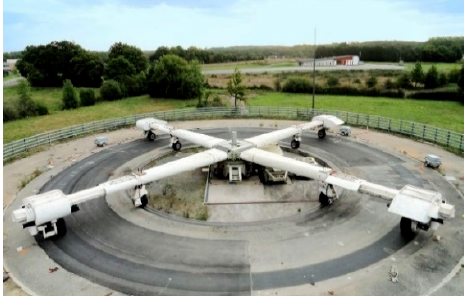
Figure 11. carrousel APT at IFSTTAR. Figure 11. Carrousel APT at IFSTTAR.